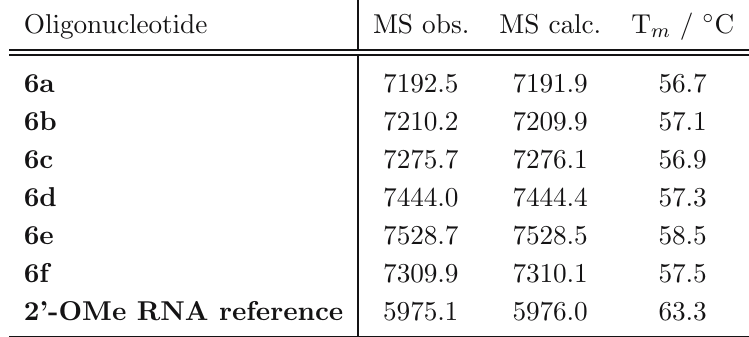
Table 1 Melting temperatures and molecular weights of oligonucleotide probes 6a-f and the reference sequence (GCU GCC UCC CGU AGG AGU). UV-melting studies were measured in 10 mmol L − 1 KH 2 PO 4 buffer, pH 7.0, 0.1 mol · L − 1